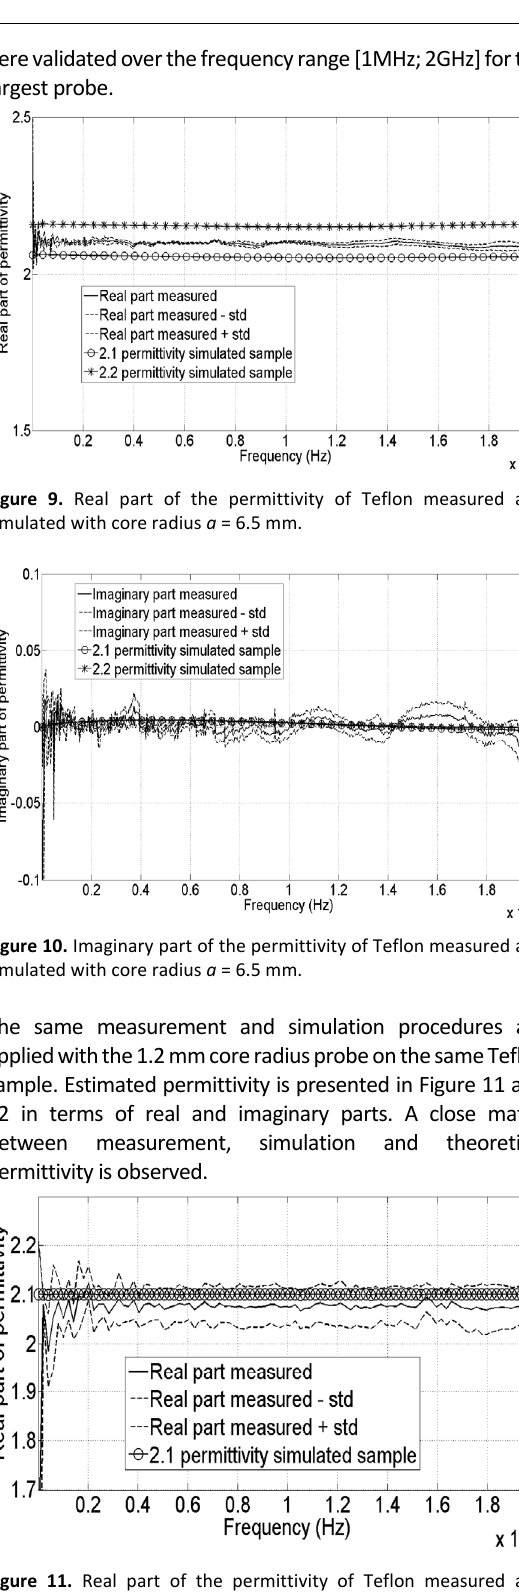
Figure 11. Real part of the permittivity of Teflon measured and simulated for the probe with core radius a = 1.2